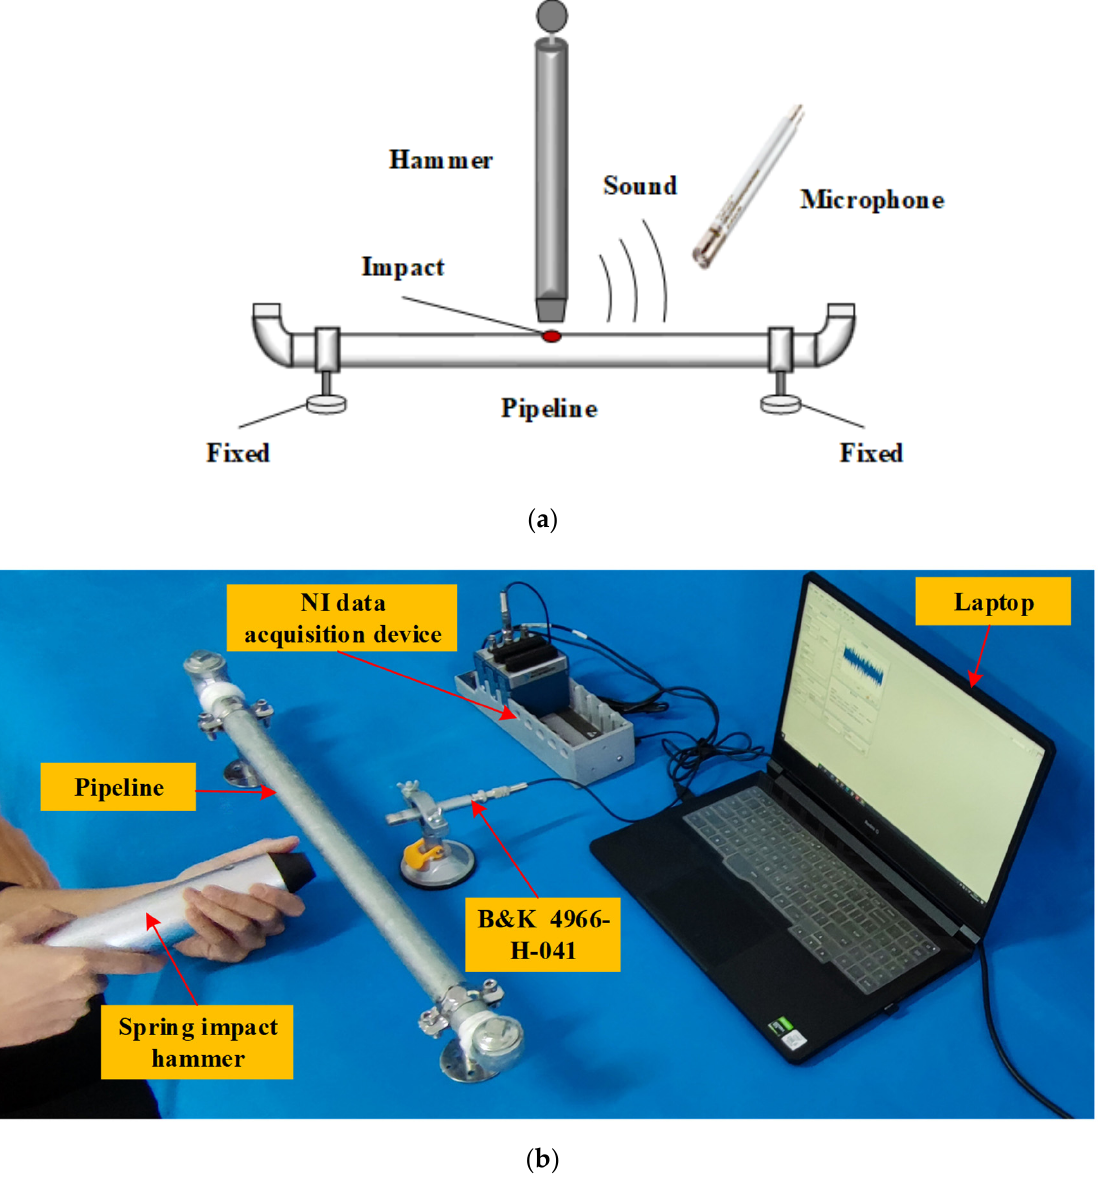
Figure 3. ( a ) Schematic of the experimental setup; ( b ) experimental setup.